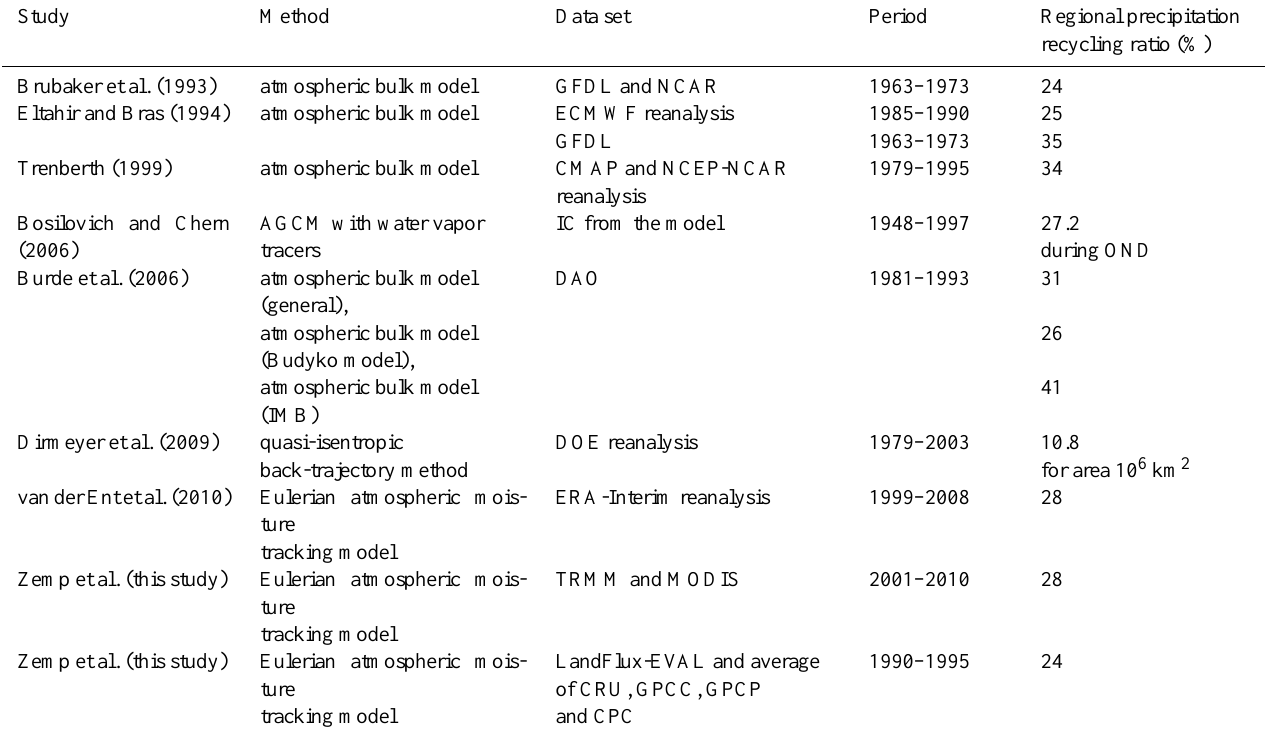
Table 2. Overview of regional precipitation recycling ratio in the Amazon basin as found in many studies. Abbreviations: the European Centre for Medium-Range Weather Forecasts (ECMWF); Geophysical Fluid Dynamics Laboratory (GFDL); Climate Prediction Center Merged Analysis of Precipitation (CMAP); initial conditions (IC); October-November-December (OND); Data Assimilation Office (DAO); integral moisture balance (IMB); National Centers for Environmental Prediction (NCEP) – Department of Energy (DOE); World Monthly Surface Station Climatology distributed by the National Center for Atmospheric Research